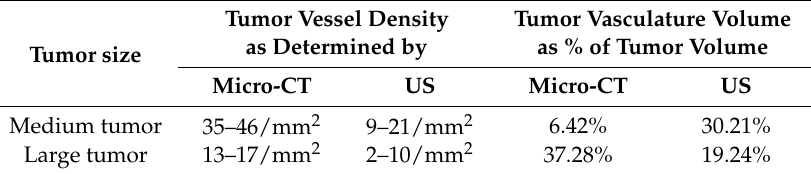
Table 2. Comparison of tumor vessel density and percentage of tumor vessel volume within the tumor estimated with micro-CT and US. Tumor vessel density is expressed as a range of all values. Tumor Vessel Density as Determined Tumor size